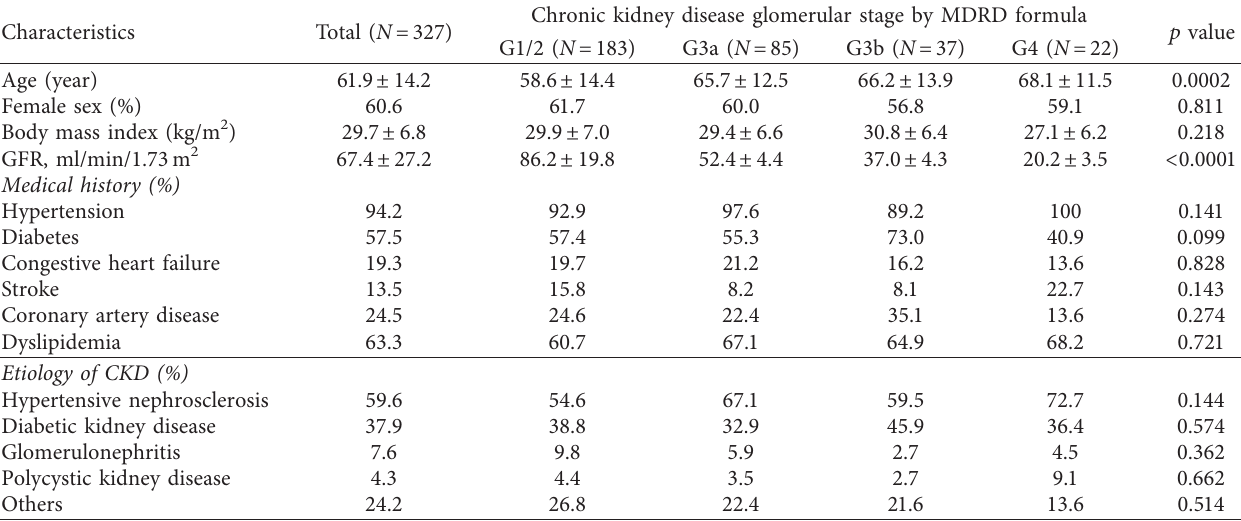
Table 1: Patient characteristics.